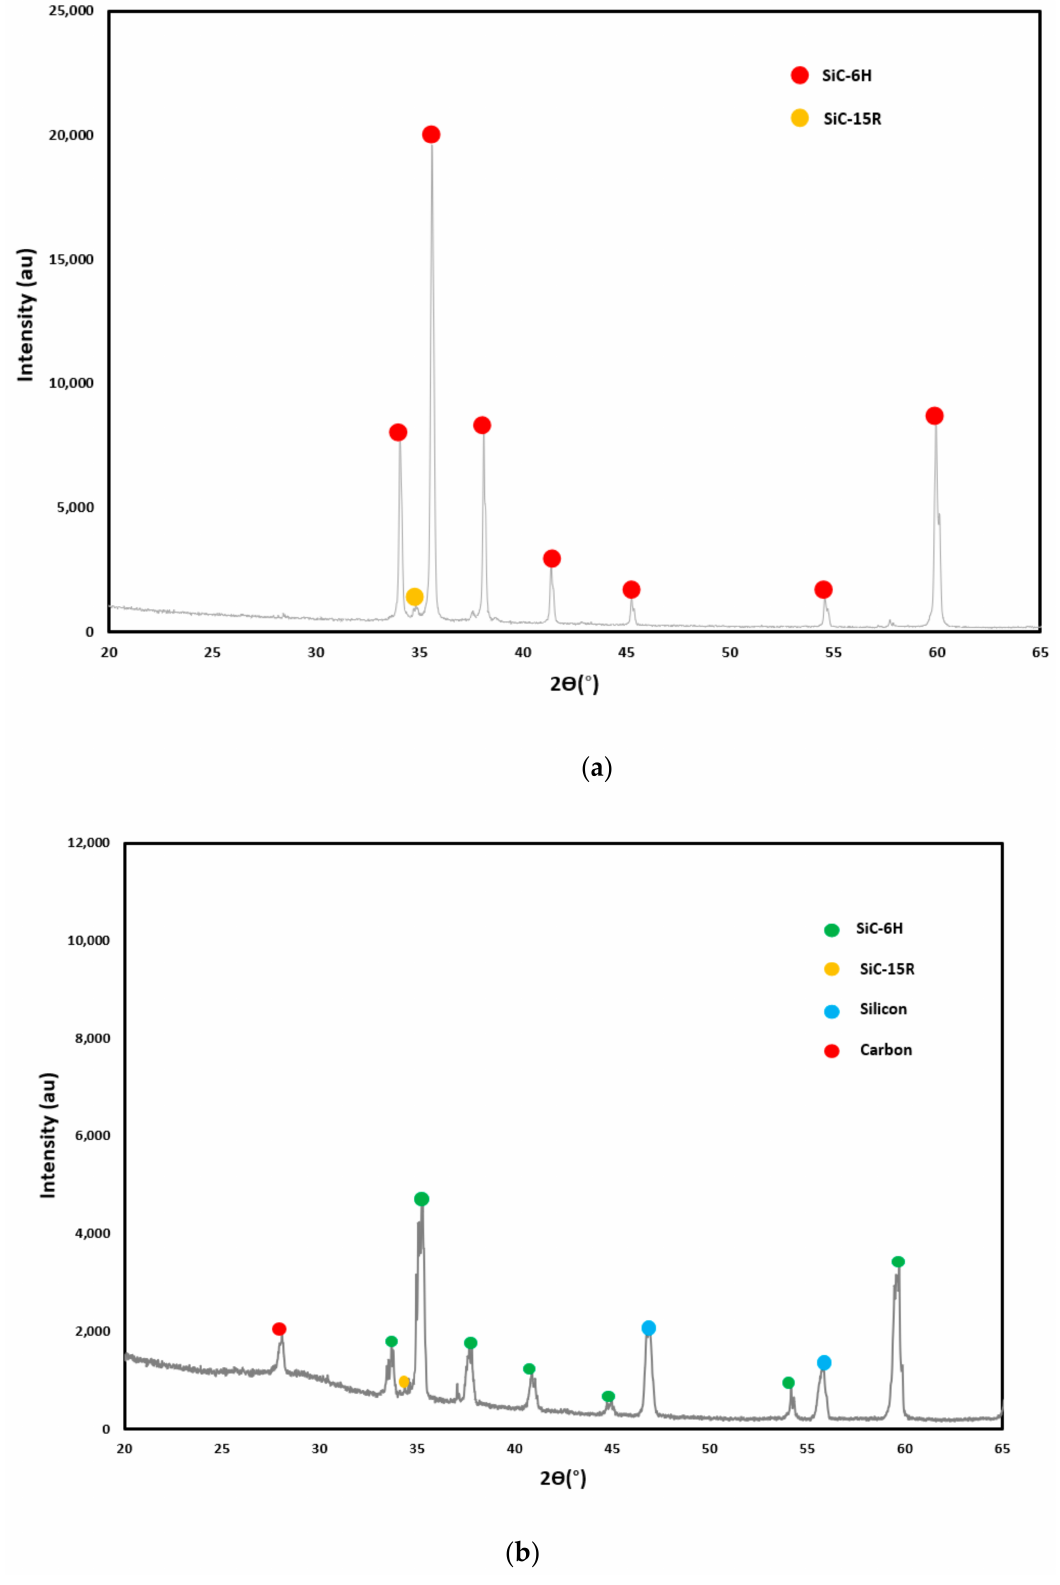
Figure 15. XRD spectra of the SiC powder and SiC manufactured part by D-PBSLP. ( a ) XRD spectra of the SiC powder; ( b ) XRD spectra of the SiC